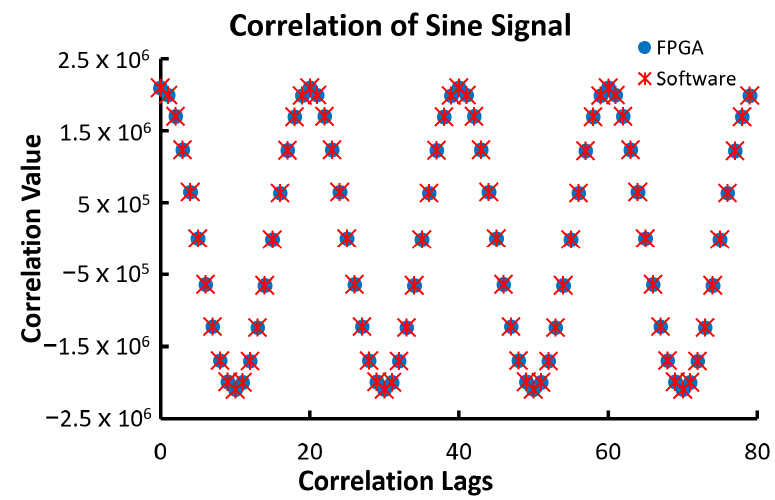
Figure 14. The outputs of 80 correlation lags of a sine signal with the amplitude of 2047 and the period of 20 data points from the FPGA correlator and the software correlator. Table 2 is the MSE between the FPGA linear correlator and the software linear corre- lator. The MSE of zero demonstrated both outputs were identical. Table 2. MSE of the linear correlator.